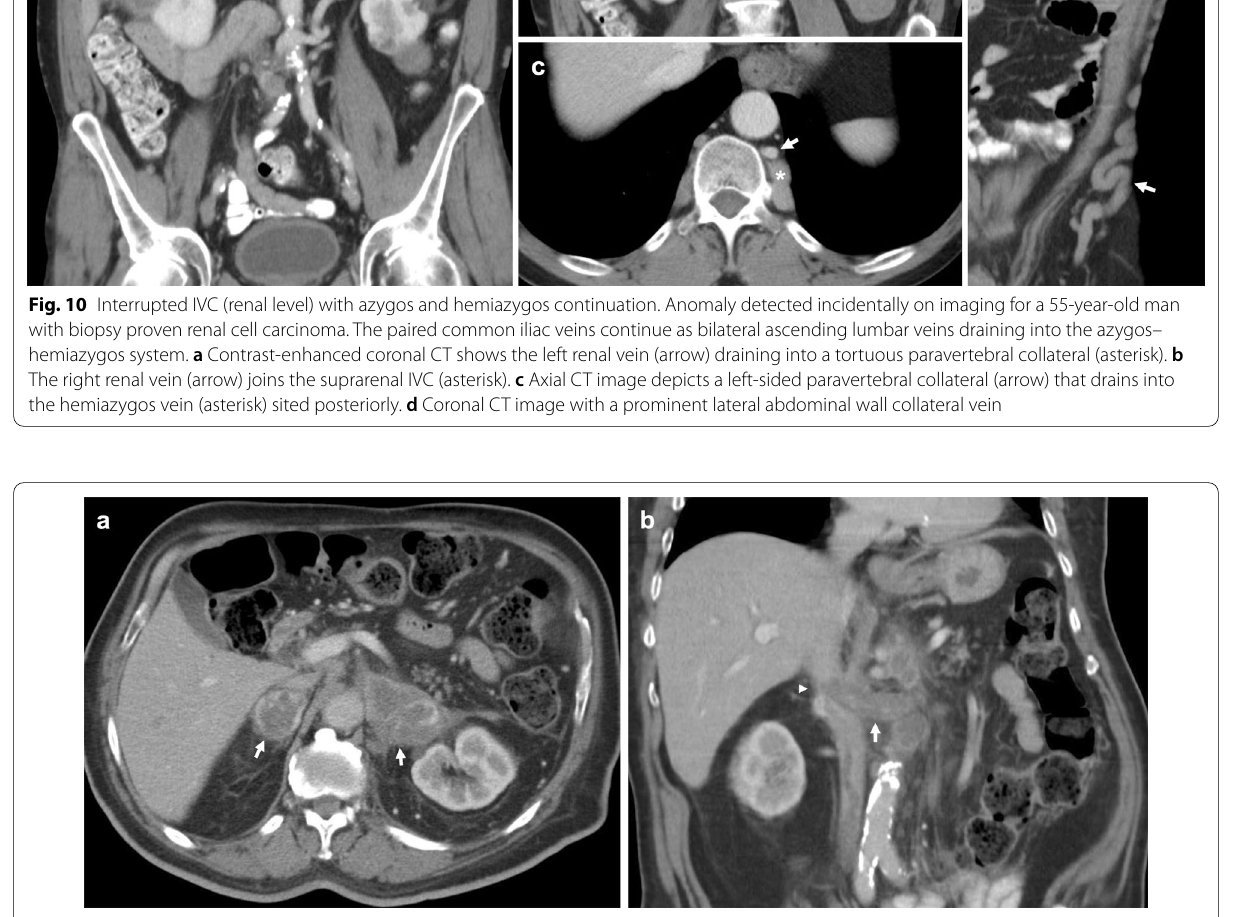
Fig. 11 Adrenal metastases with suprarenal IVC tumour thrombus in a patient with small cell lung carcinoma primary. a Axial CT shows bilateral suprarenal lesions with heterogeneous peripheral enhancement in keeping with bilateral adrenal metastases. b Coronal CT demonstrates extension of tumour into the left renal vein (arrow) and suprarenal IVC (arrowhead). The heterogeneous appearance of the suprarenal IVC is due to a combination of tumour thrombus and flow